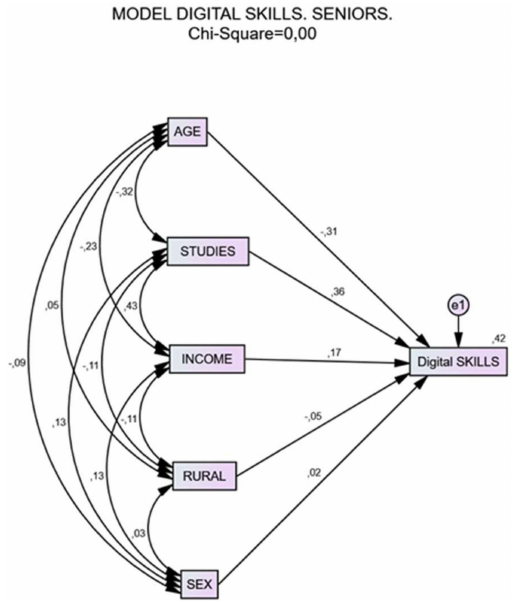
Figure 4. Digital Skills Senior Population